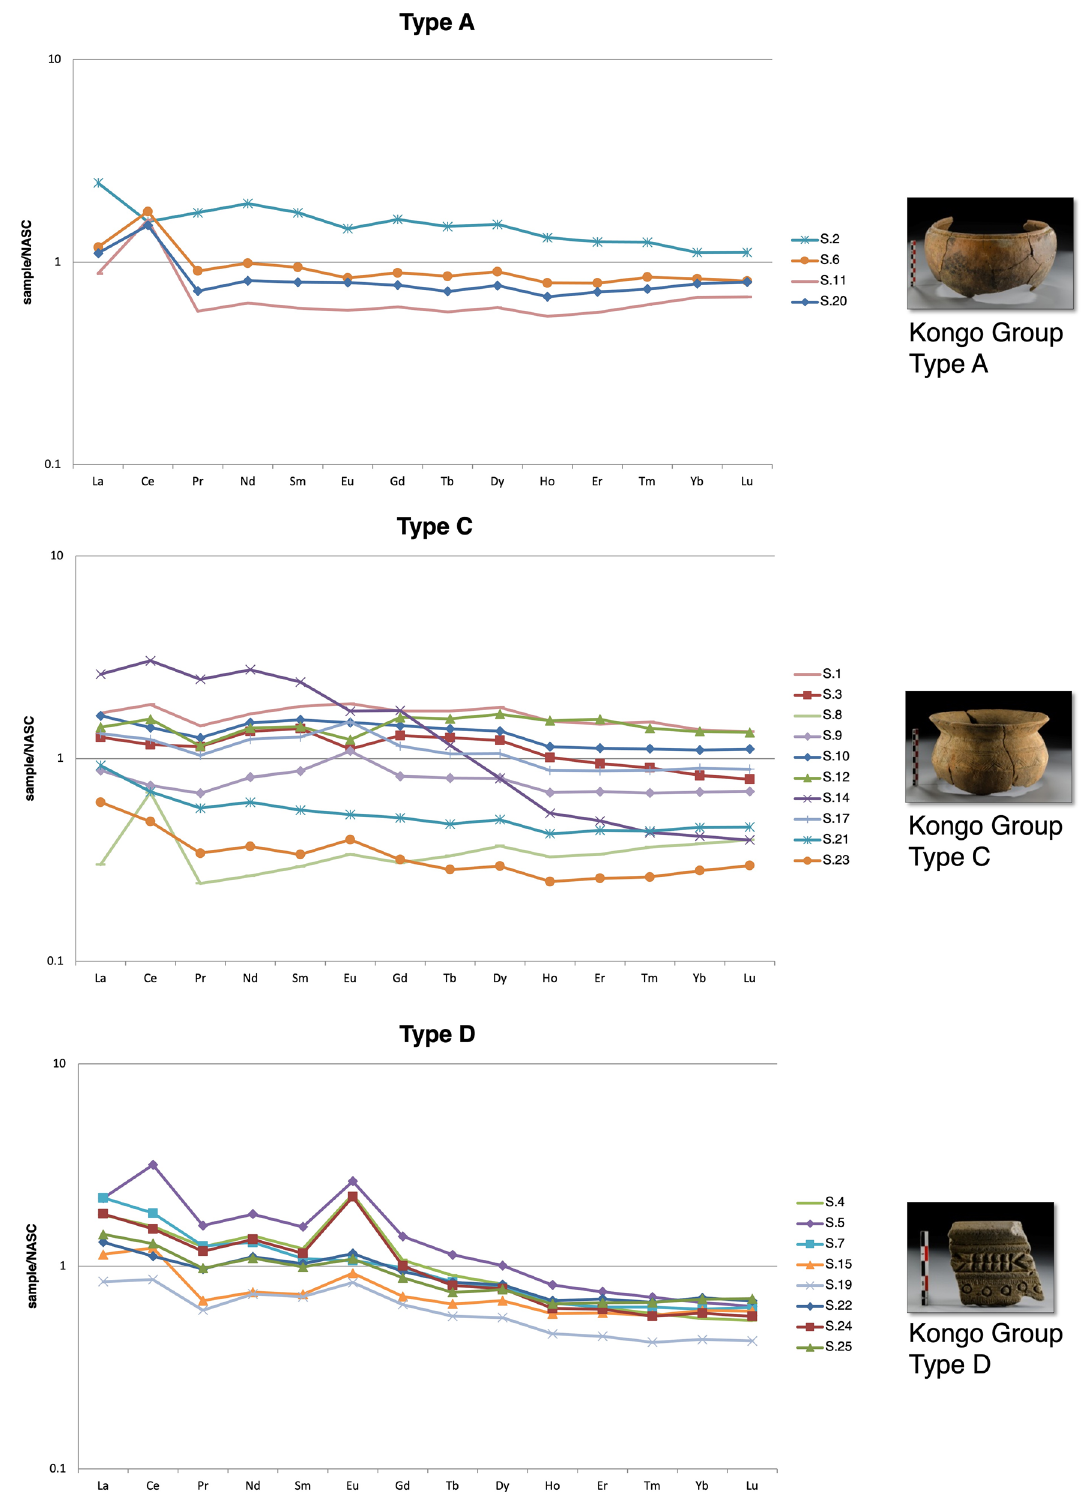
Figure 9. ICP-MS data. NASC-normalized REE diagram of the samples from Mbanza Kongo